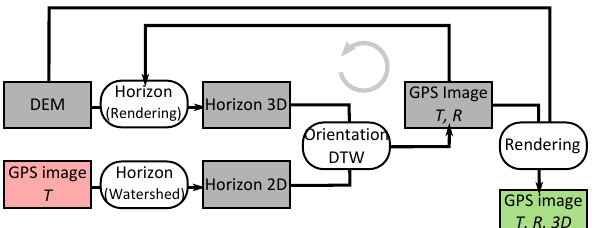
Figure 1: Processing of the GPS images, T refers to the camera location measured with the GPS, R is the orientation of the cam- era. At the end of this step, each GPS-image pixel owns a 3D coordinate.